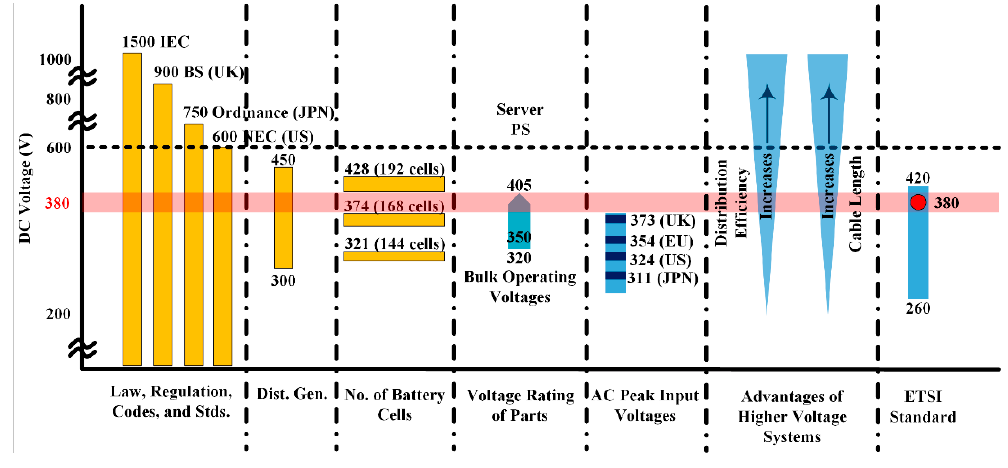
Figure 9. DC bus voltage level selection [47]. Table 4. Global DC distribution systems